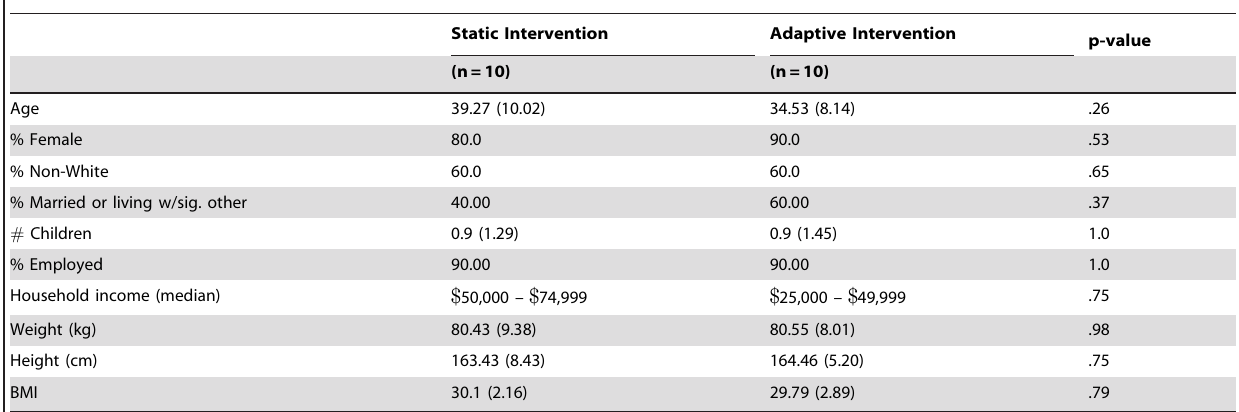
Table 1. Demographics and personal characteristics by group. a